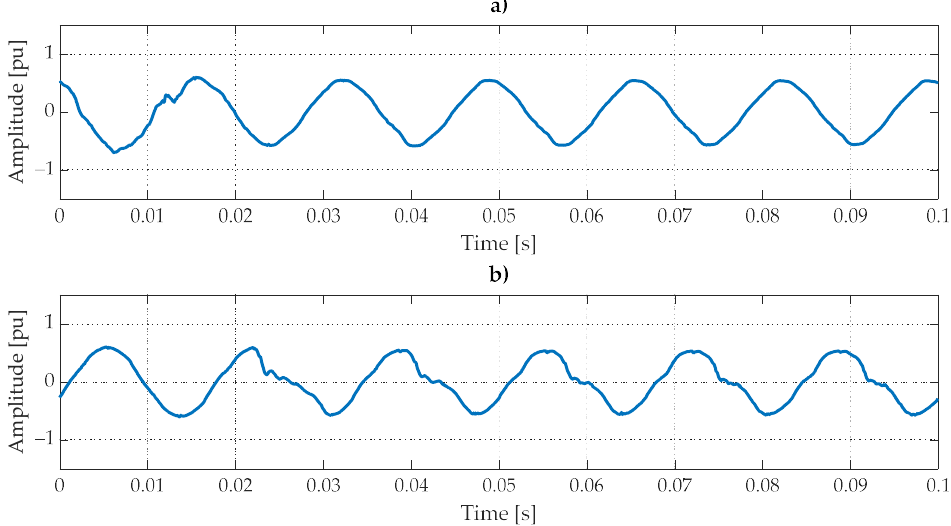
Figure 4. Real database signal. ( a ) Sag disturbance; ( b ) Sag with harmonics.